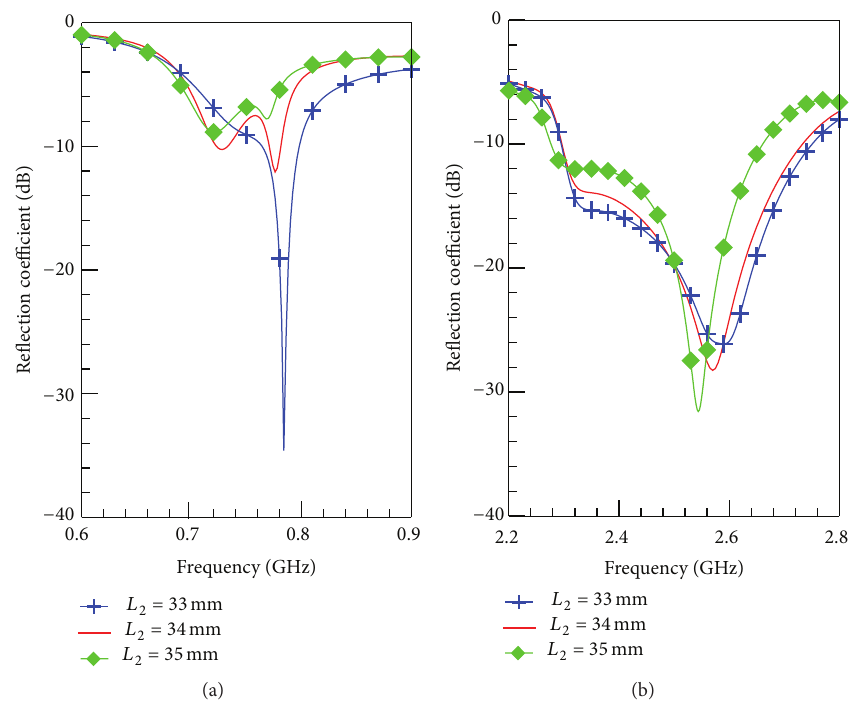
Figure 7: Simulated reflection coefficient of the proposed antenna as the function of 𝐿 2 .